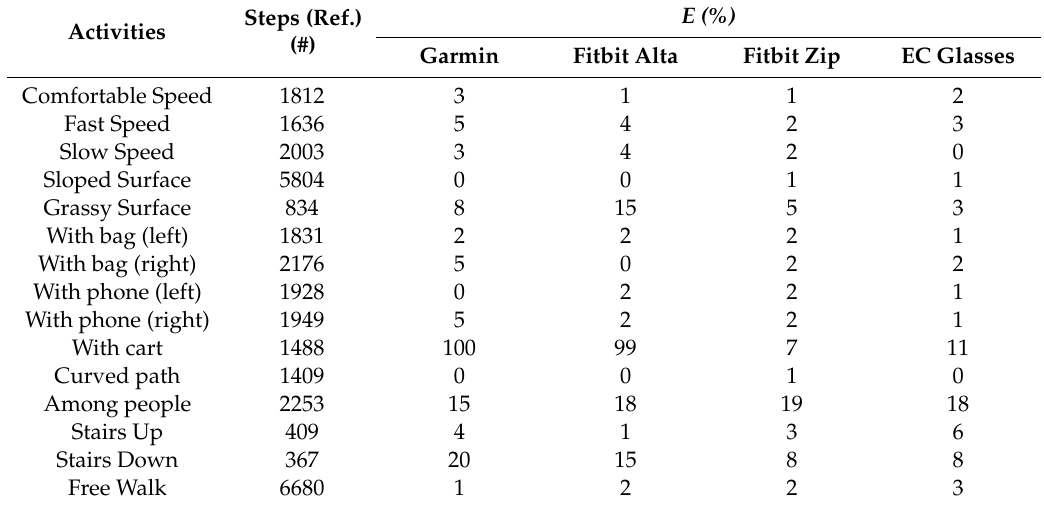
Table 3. E of devices for every performed